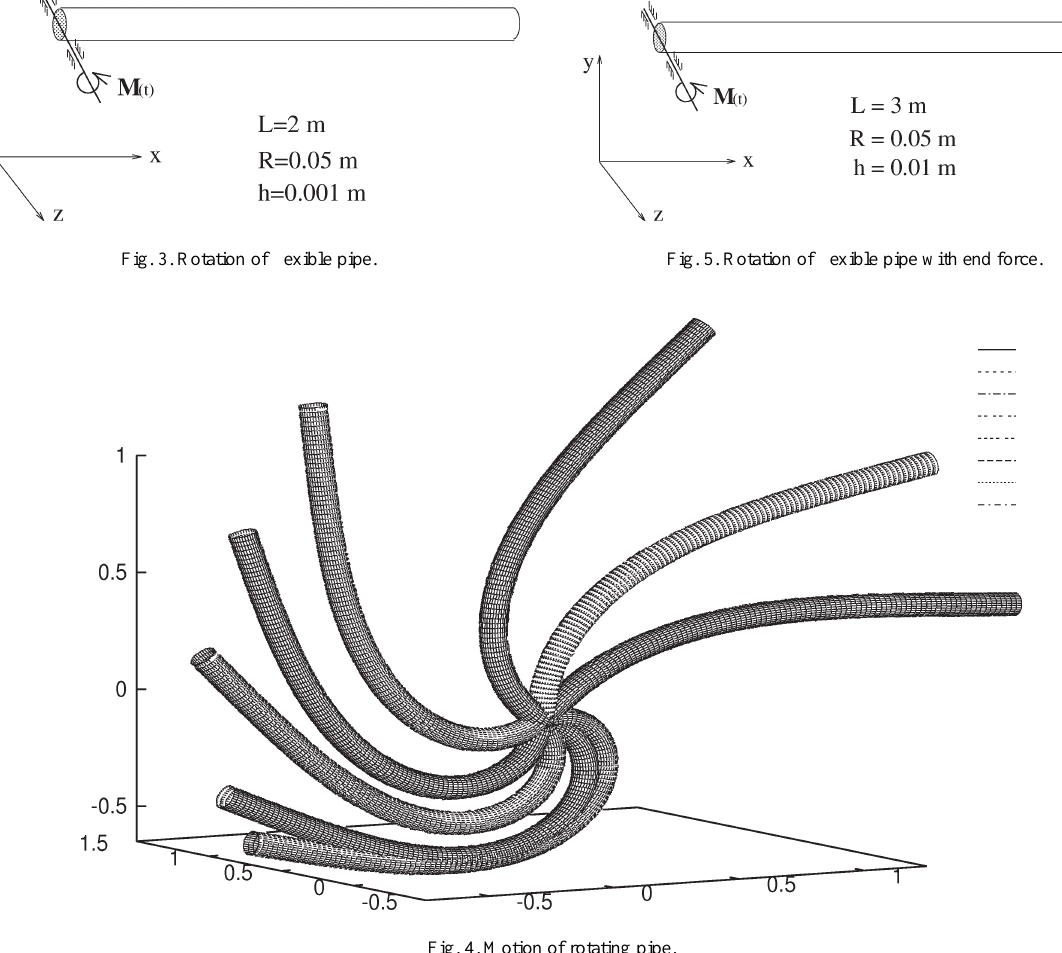
Fig. 4. Motion of rotating